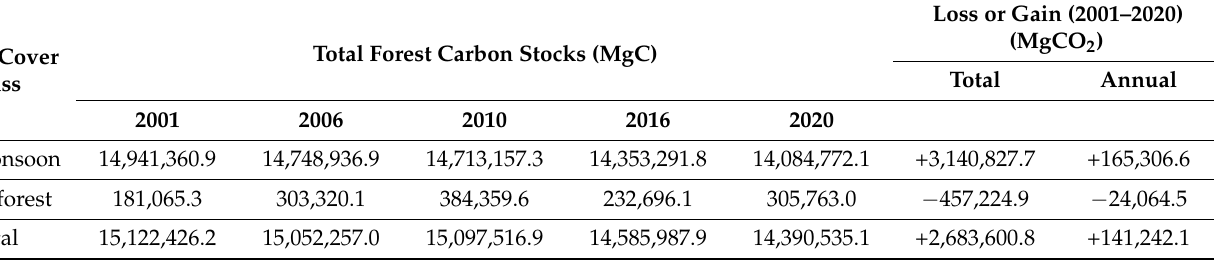
Table 7. Changes in forest carbon stocks by forest type between